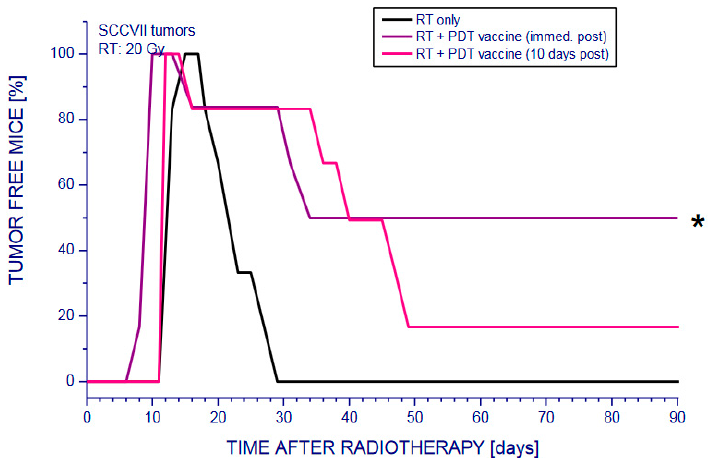
Figure 1. The response of mouse SCCVII tumors to PDT vaccines combined with radiotherapy. Mice bearing SCCVII tumors received a peritumoral injection of SCCVII cells that were treated in vitro by ce6-PDT followed by 16 h post-incubation in culture, as described in detail elsewhere [47]. For radiotherapy, the tumors were exposed to X-rays (20 Gy) with mice immobilized in lead holders. The mice were then monitored 90 days for signs of tumor regrowth and those remaining impalpable after this interval were considered cured. Each treatment group consisted of 6 mice. * Statistically significant difference ( p < 0.05) compared with other treatment groups. The result for PDT vaccine alone treatment was presented elsewhere [46].